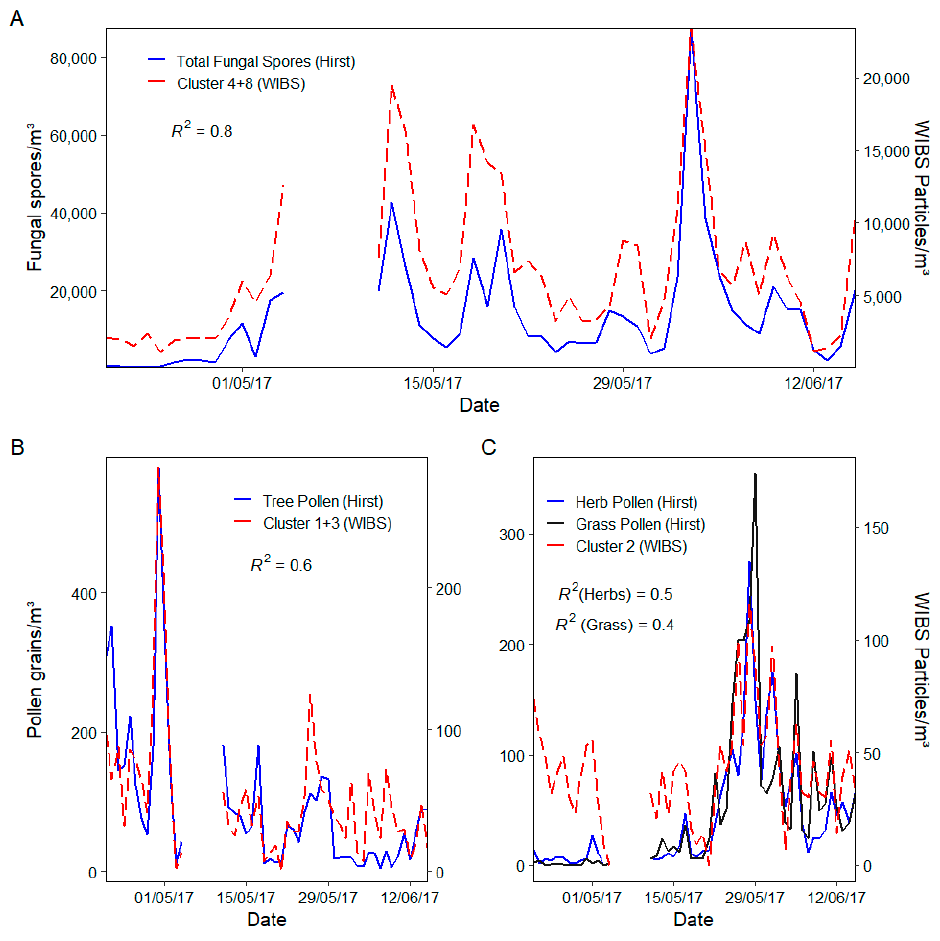
Figure 9. ( A ) Daily time series of Hirst fungal spore concentrations vs. resulting WIBS K-means clusters (4 + 8), ( B ) Daily time series of Hirst tree pollen concentrations vs. resulting WIBS K-means clusters (1 + 3) and ( C ) Daily time series of Hirst grass/herb pollen concentrations vs. resulting WIBS K-means clusters (2) .